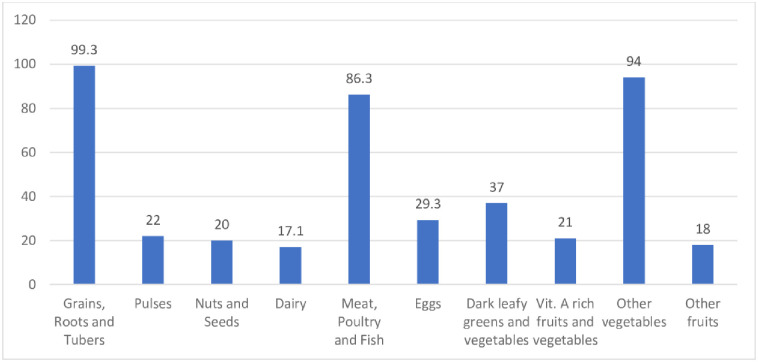
Proportions of adolescents consuming different food groups previous the 24 hours.